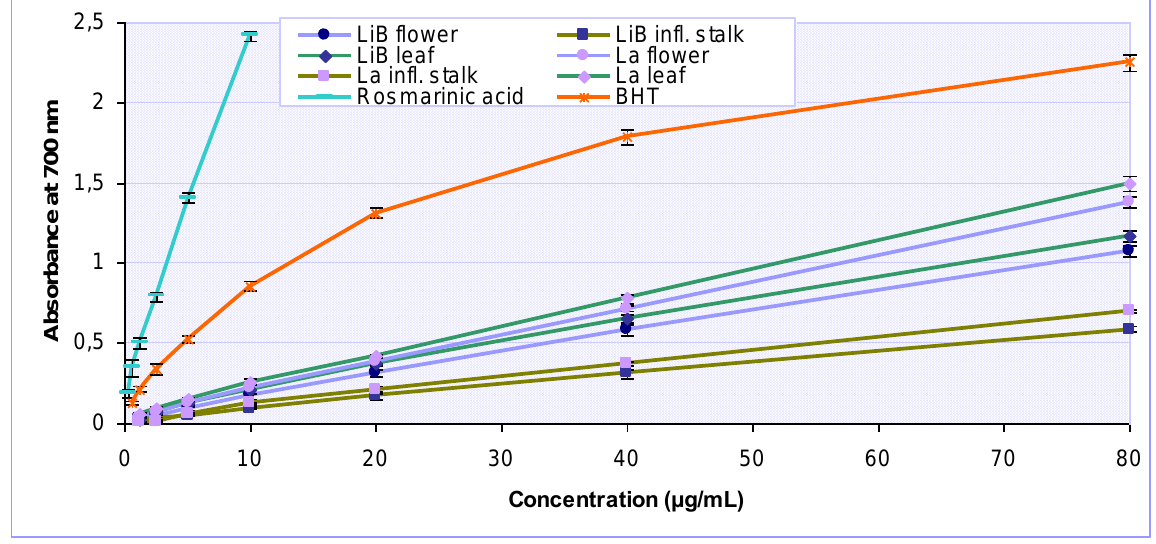
Figure 4. Reducing power of various Lavandula x intermedia 'Budrovka' (LiB) and L. angustifolia (La) extracts as well as rosmarinic acid at different concentrations. BHT was used as